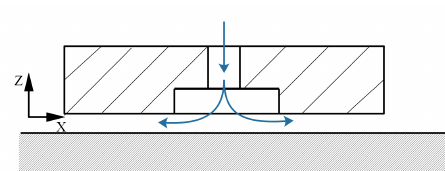
Figure 1. Schematic diagram of gas film